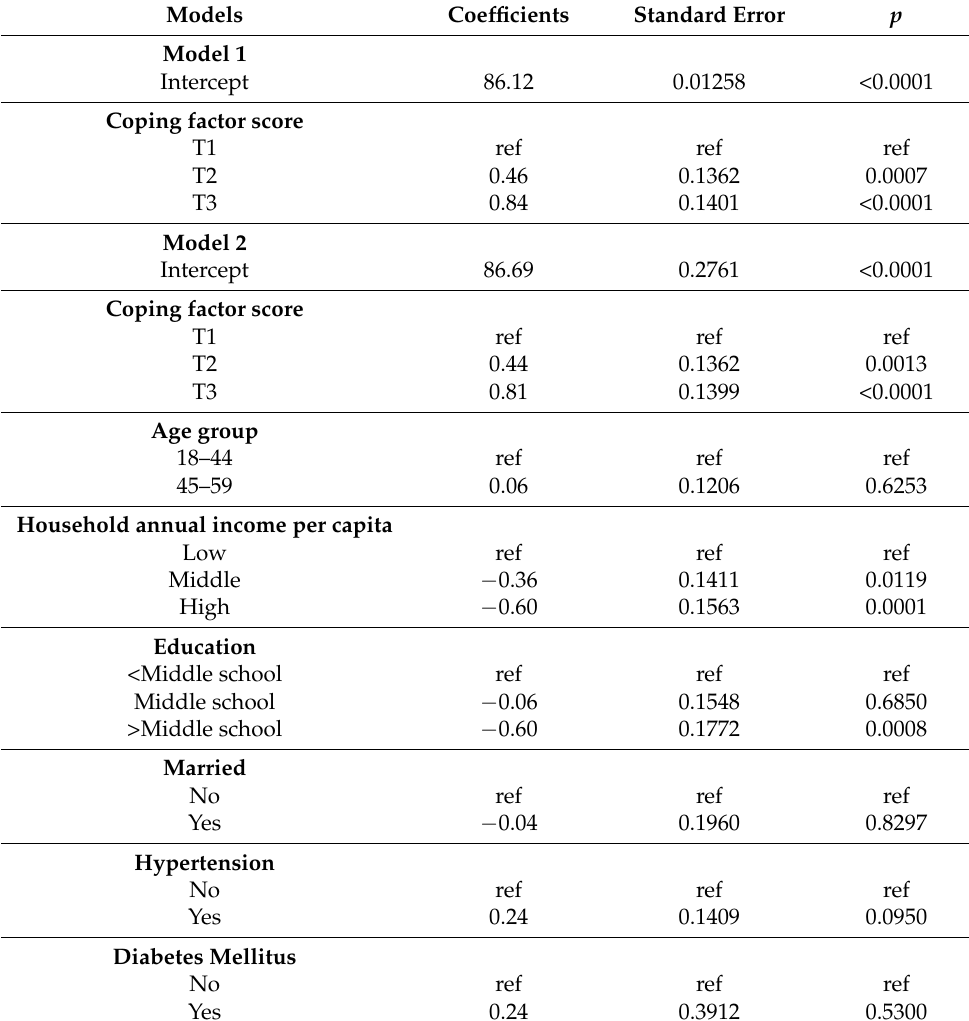
Table 4. The effects of coping factor on energy intake from carbohydrate and fat in females.